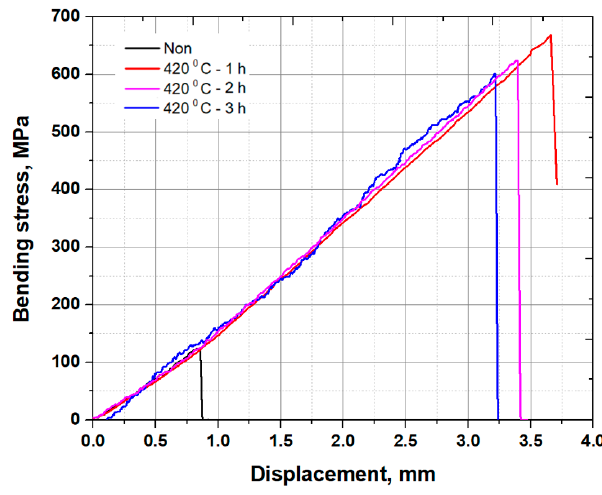
Figure 7. Bending test results of the non-strengthened and chemically strengthened glasses.